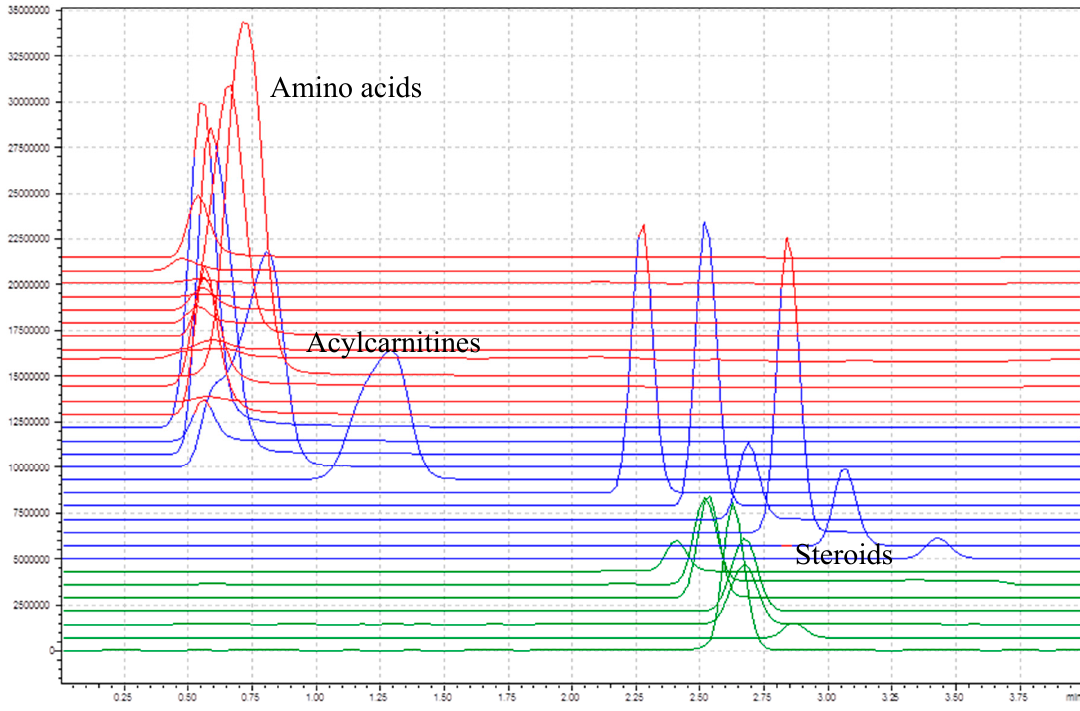
Figure 2. Total ion chromatogram (TIC) of all unlabeled target compounds (amino acids in red, acylcarnitines in blue and steroids in green).